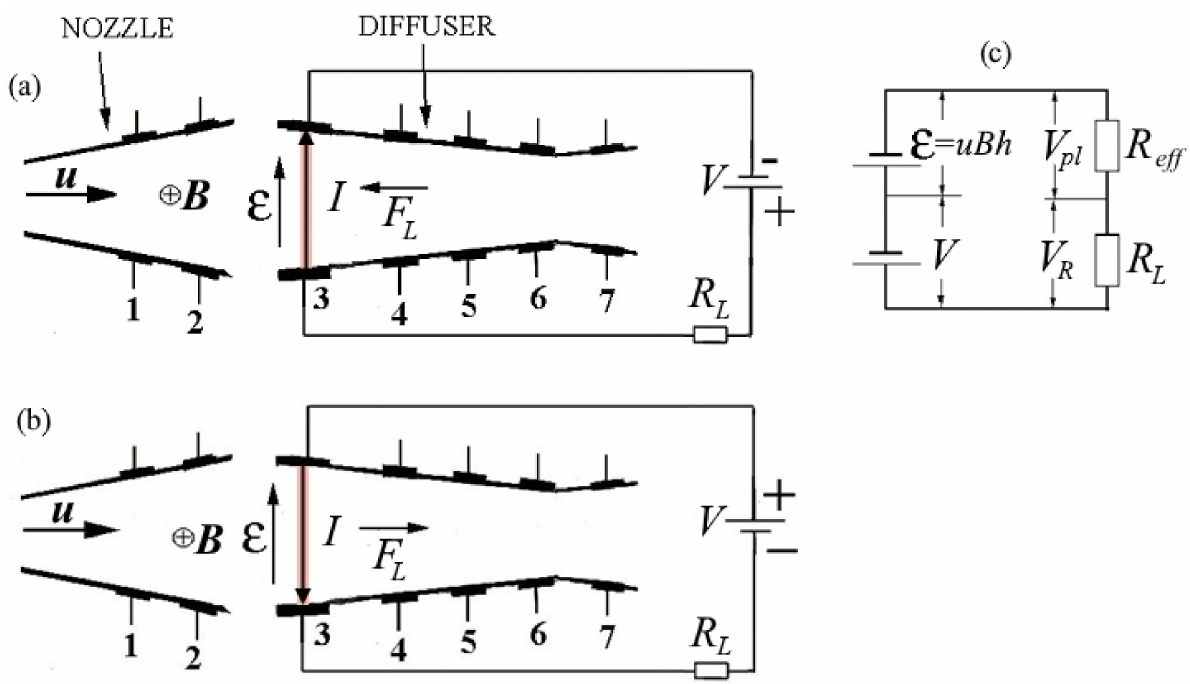
Figure 5. ( a ) Scheme of transverse connection of electrodes in braking mode; ( b ) Scheme of transverse connection of electrodes in accelerating mode; ( c ) Equivalent wiring